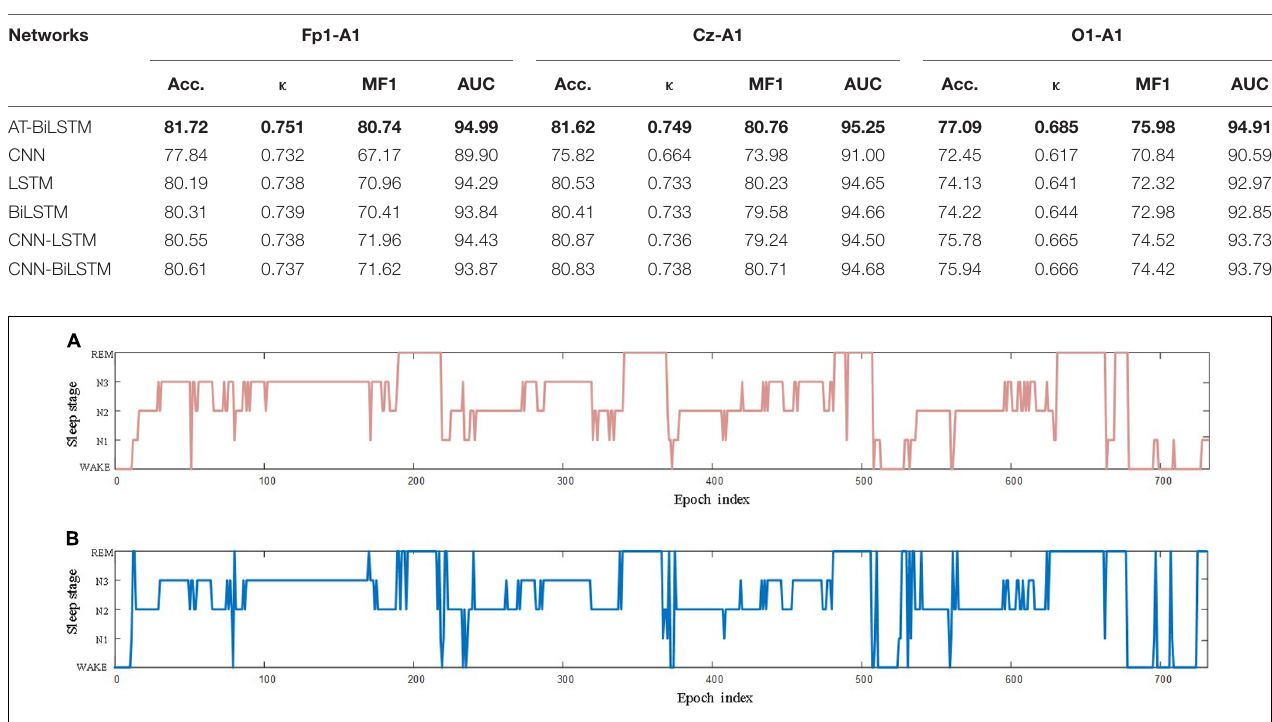
FIGURE 4 | The hypnograms labeled (A) manually by a clinical technician of sleep and (B) by the trained AT-BiLSTM model. The corresponding EEG recoding was obtained from PSEE dataset (SC4001E0). TABLE 5 | The class-wise performance obtained on the PSEE dataset (value in bold represents for the best among all the networks). EEG signal Networks